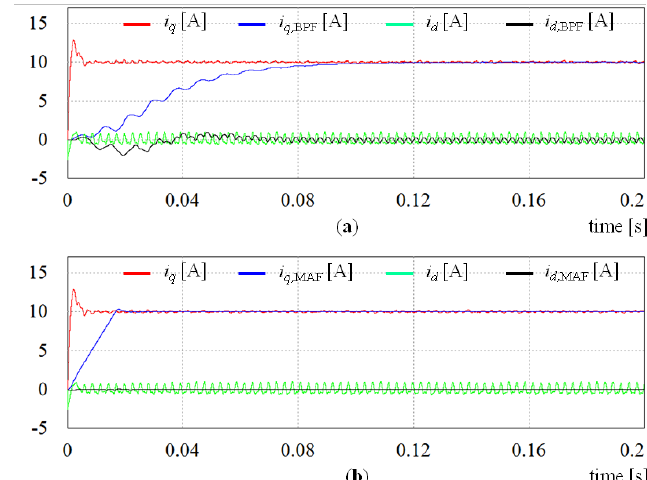
Figure 6. Performance comparison of dynamic responses between the BPF and MAF when DC-quantity of inverter currents is extracted at the synchronous frame under the distorted grid voltages: ( a ) using BPF; and ( b ) using MAF.